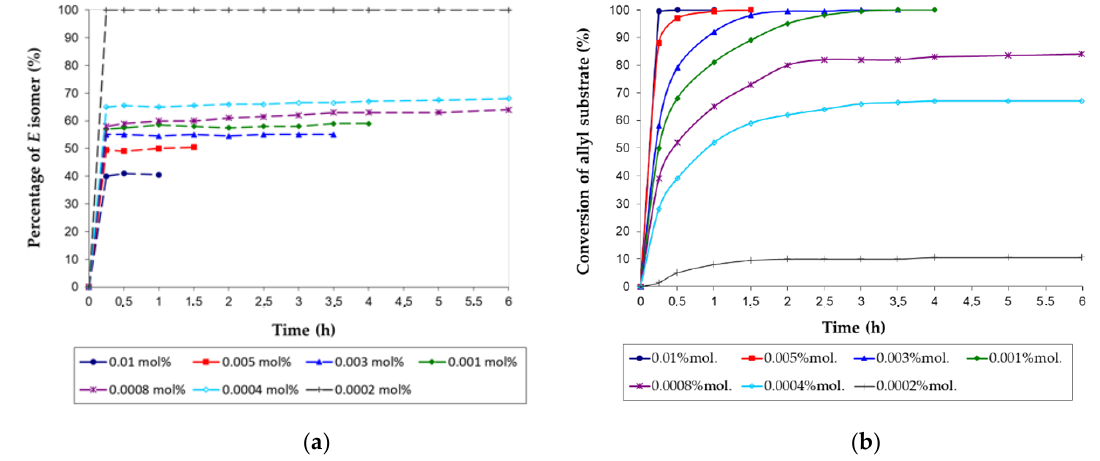
Figure 2. The e ff ect of the [RuClH(CO)(PPh 3 ) 3 ] pre-catalyst concentration on the isomerization of the hydroperoxide-free 4-allyloxybutan-1-ol to ( Z )- and ( E )-4-(1-propenyloxy)butan-1-ol: ( a ) variation of the allyloxyalcohol conversion and ( b ) variation of the reaction stereoselecivity to E -1-propenyl isomer (the reaction conditions: scale 150 mmol, 80 ◦ C, argon atmosphere, magnetic